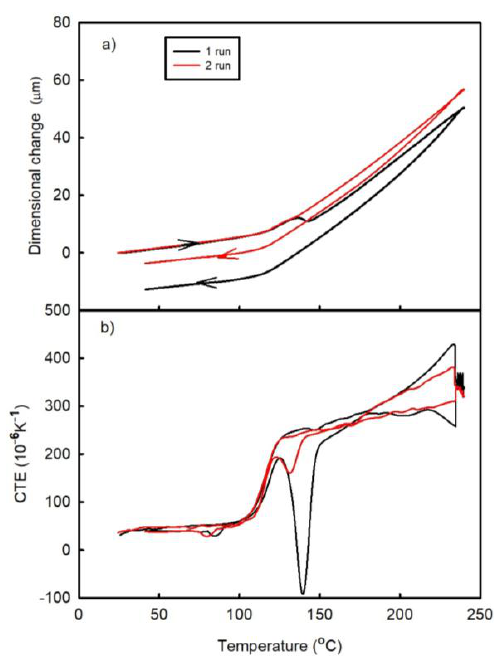
Figure 3. Temperature dependences of the ( a ) dimensional changes and ( b ) CTE of the A1 sample (FR4 laminate) observed after two runs.